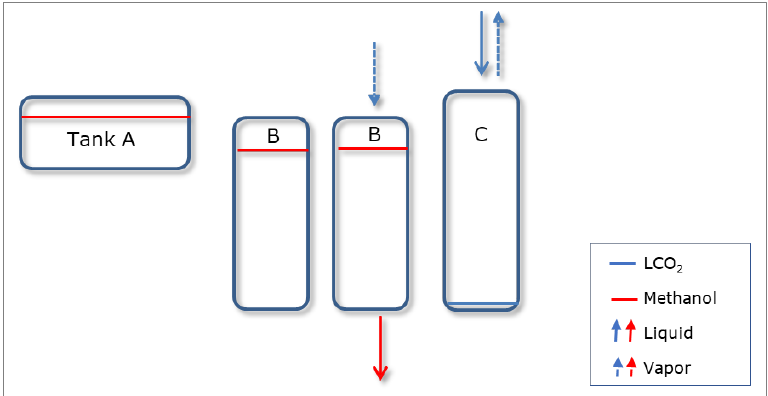
Figure 5. Combined methanol / CO 2 tank